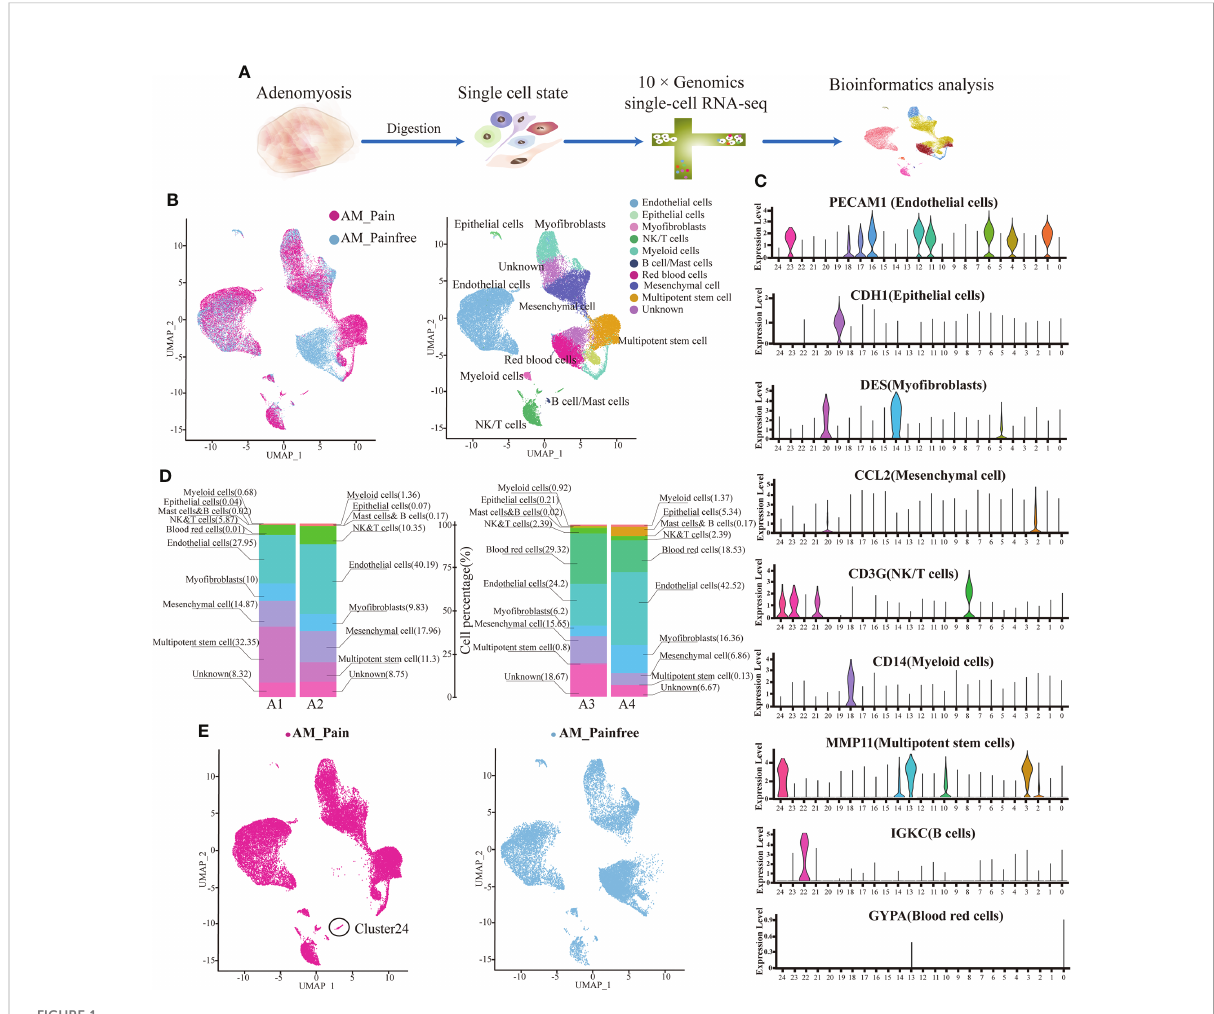
FIGURE 1 Identi fi cation of adenomyosis populations with single-cell transcriptomic analysis. (A) The work fl ow shows the collection and processing of obtained endometrium samples of AM_Painfree and AM_Pain for scRNA-seq. (B) Uniform manifold approximation and projection visualization of all cells displayed with different colors for samples. (C) For violin plots, x-axes stand for the numbers of clusters, and y-axes stand for the relative expression level of corresponding genes. (D) Percentage of the number of cells of each type. (E) Difference in clusters between AM_Pain and AM_Painfree groups. AM,